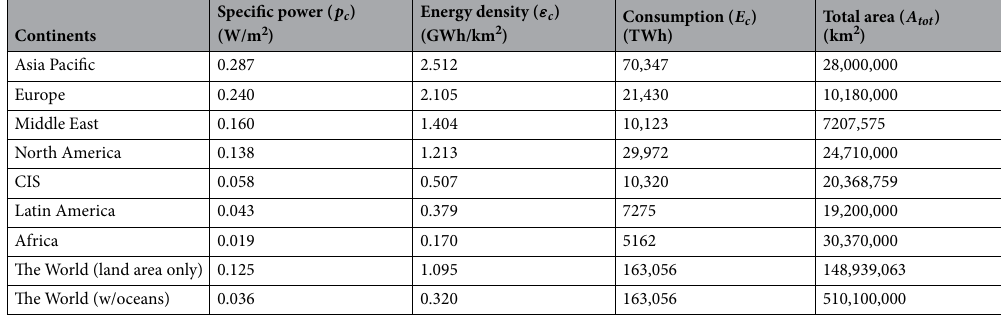
Table 15. Mean specific power and annual energy density of consumption in the different continents and regions in the world, based on a 2020 scenario 22,56 , sorted by the consumption density. The calculations are based on Eqs. (2) and (4),